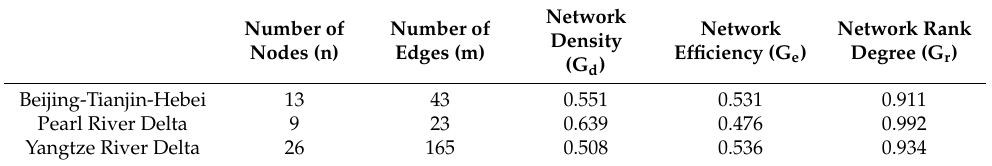
Table 1. Structural characteristics of air pollution spatial correlation weighted networks of three urban agglomerations of Beijing-Tianjin-Hebei, Pearl River Delta, and Yangtze River Delta. Number of Number of Nodes (n) Edges (m) (G d